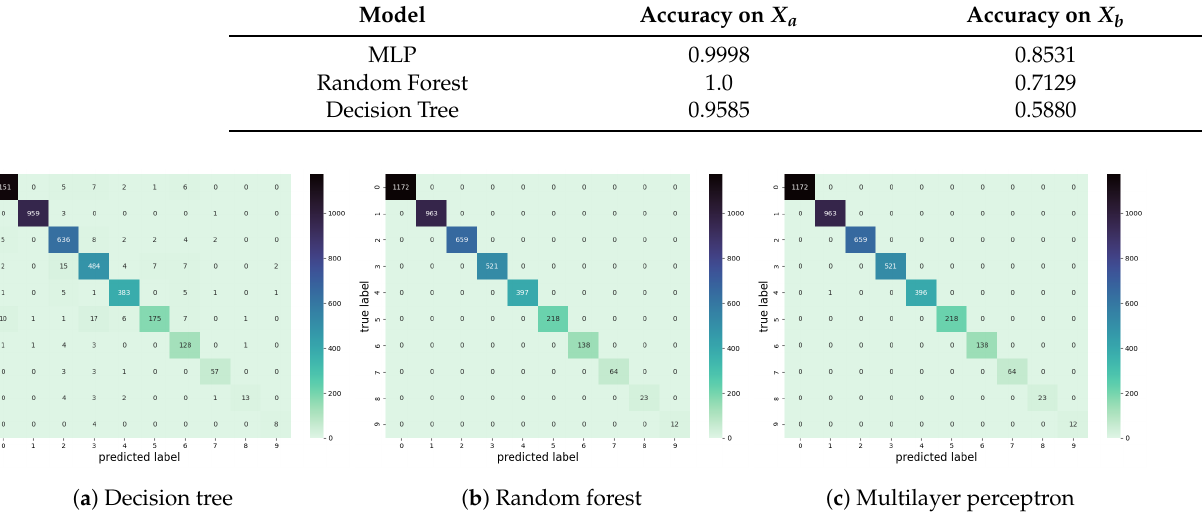
Figure 13. Confusion matrices on X a , for three classification algorithms trained on X a .